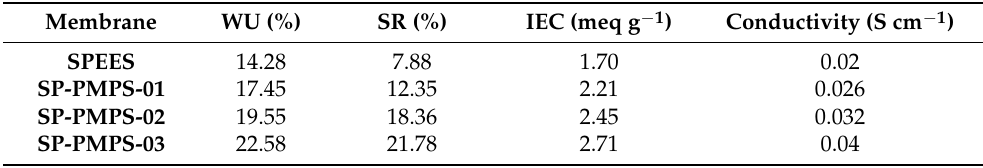
Table 1. Water uptake (WU), swelling ratio (SR), ion exchange capacity (IEC) and proton conductivity of different type of SP-PMPS